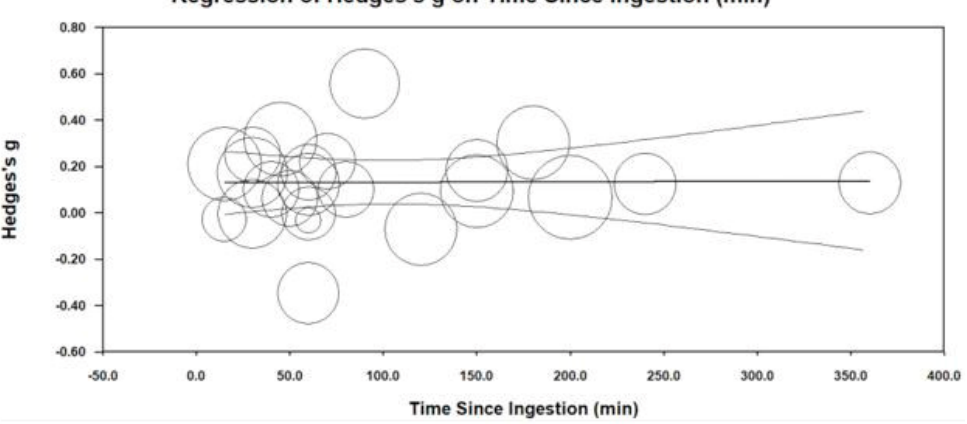
Figure 6. Meta-regression of the association between guarana ingestion time prior to cognitive testing and overall study ES. Circles indicate individual studies, with the circle size representing the individual study weight. Curved lines indicate a 95 percent confidence interval.